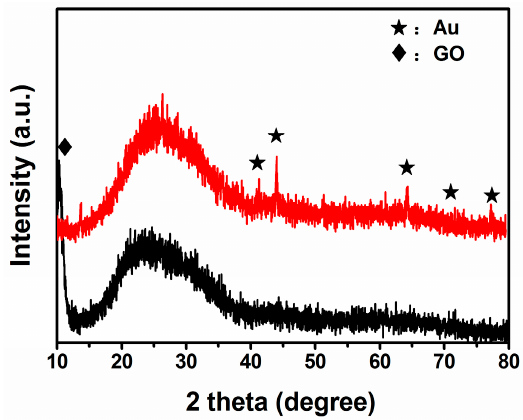
Figure 2. The XRD patterns of GO (black line) and rGO/Au (red line).